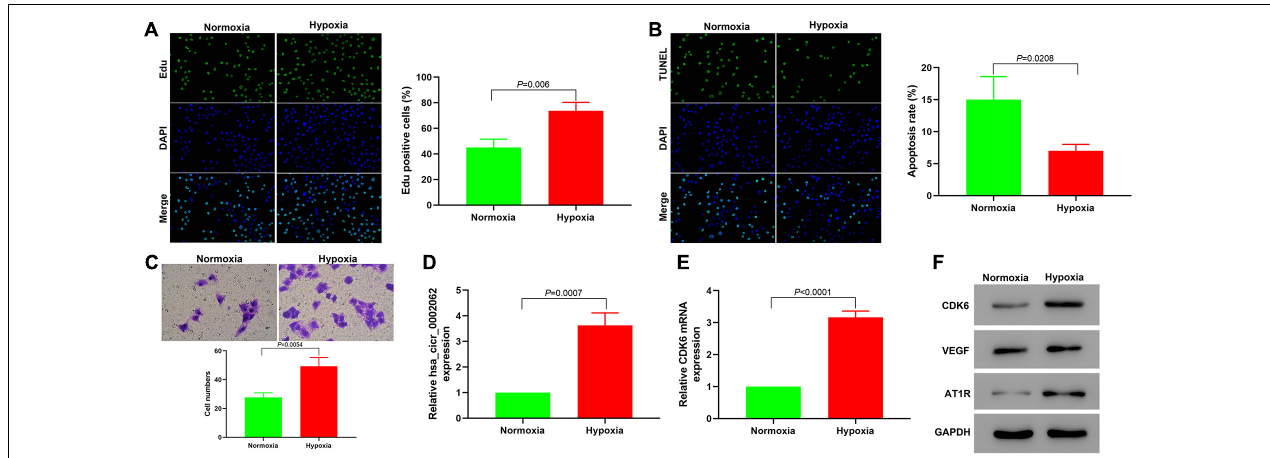
FIGURE 1 | Hypoxia promotes the proliferation and migration of hPASMCs and upregulates the expression of hsa_circ_0002062 and CDK6. (A–C) Based on the results of Edu incorporation assays (A) , TUNEL assays (B) , and Transwell assays (C) , cell proliferation and migration were elevated, while the apoptosis rate of hypoxic PASMCs decreased under hypoxia compared to normoxic conditions ( p < 0.01). (D,E) Relative expression levels of hsa_circ_0002062 and CDK6 mRNA were significantly upregulated in the hypoxic group compared with the control group. (F) Under hypoxia, the protein expression levels of CDK6, VEGF, and AT1R were significantly upregulated. Error bars represent the mean ± SD from triplicate experiments. Image magnification: × 200.